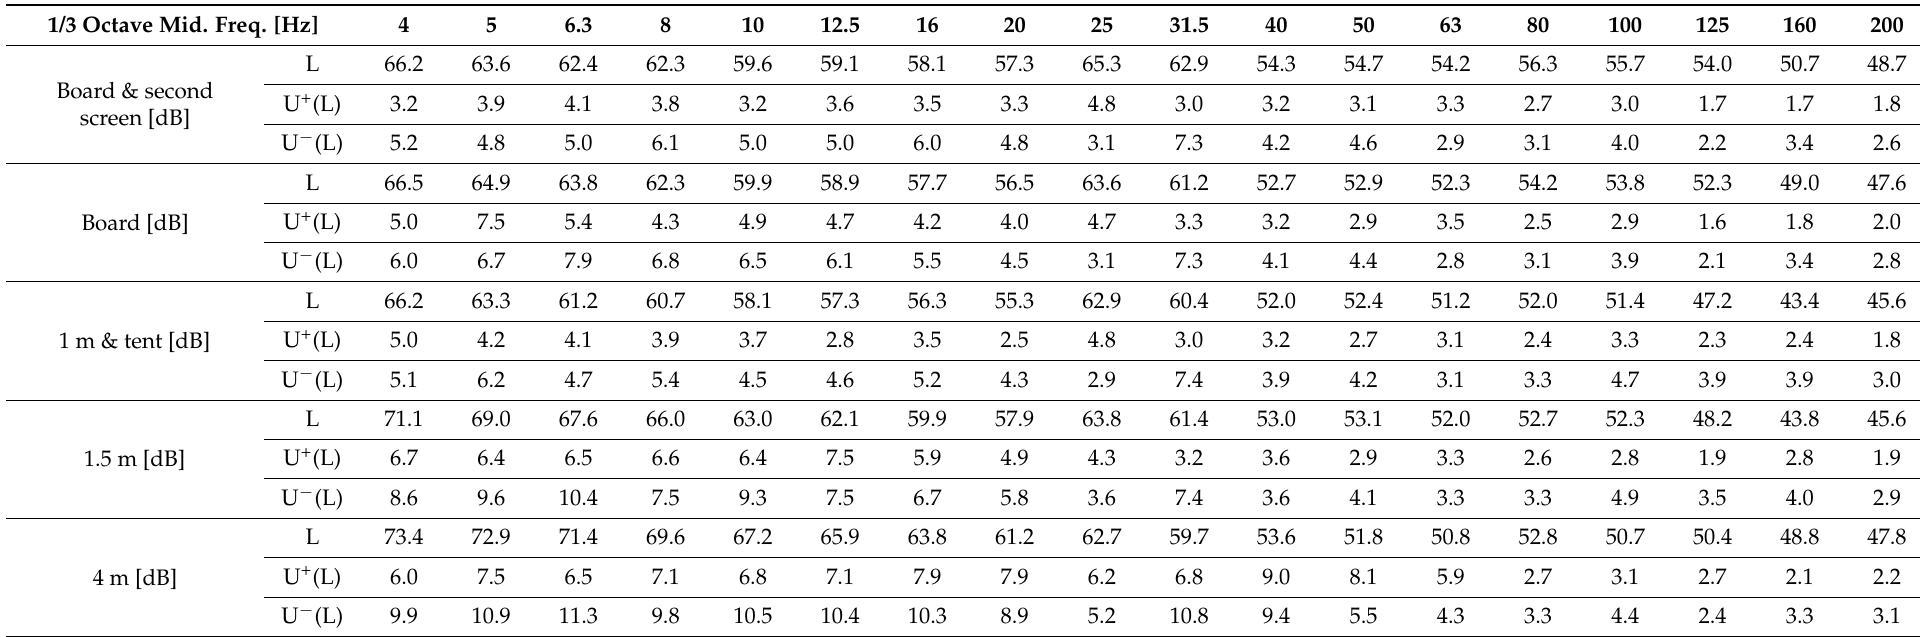
Table 4. The sound pressure level in the 1/3 octave bands and the limits of the confidence intervals for the tested measurement configurations, average wind speed—2.1 m/s, max wind speed—4.5